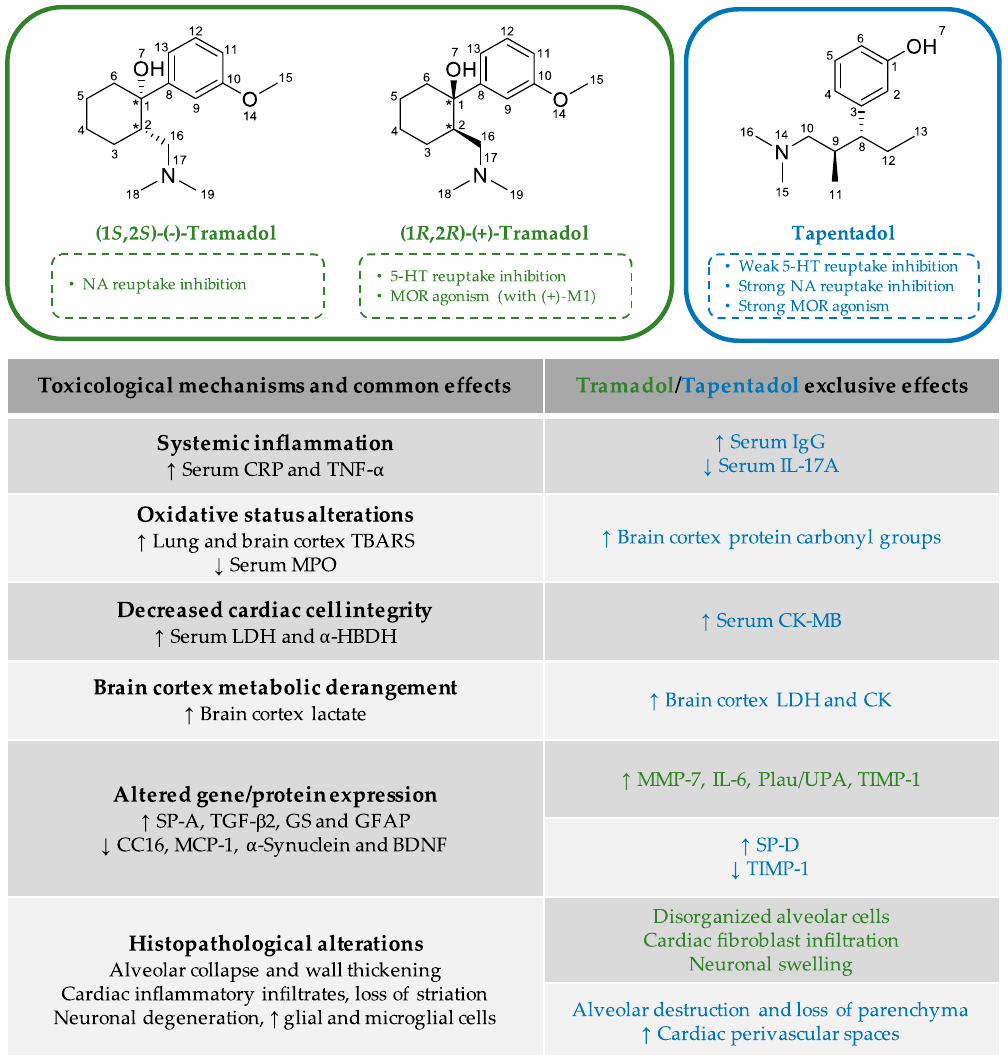
Figure 10. Summary of the toxicological mechanisms associated with a 14-day exposure of Wistar rats to clinically relevant doses of tramadol or tapentadol. 5-HT: serotonin; α -HBDH: α -hydroxybutyrate dehydrogenase; BDNF: brain-derived neurotrophic factor; CC16: Clara cell protein-16; CK-MB: creatine kinase muscle brain isoform; CK: creatine kinase; CRP: C reactive protein; GFAP: glial fibrillary acidic protein; GS: glutamine synthetase; IgG: immunoglobulin G; IL-17A: interleukin-17A; IL-6: interleukin-6; LDH: lactate dehydrogenase; M1: O -desmethyltramadol; MCP-1: monocyte chemoattractant protein-1; MMP-7: matrix metalloproteinase-7; MOR: μ -opioid receptor; MPO: myeloperoxidase; NA: noradrenaline; Plau/UPA: plasminogen activator, urokinase; SP-A: pulmonary surfactant protein A; SP-D: pulmonary surfactant protein D; TBARS: thiobarbituric acid reactive substances; TGF- β 2: transforming growth factor- β 2; TIMP-1: tissue inhibitor of metalloproteinase-1; TNF- α : tumor necrosis factor- α .